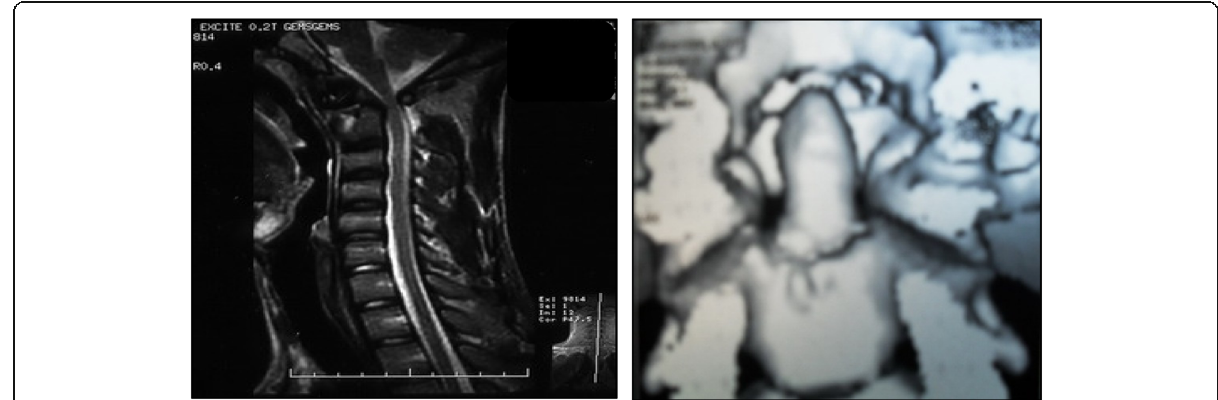
Fig. 3 MRI cervical spine and coronal 3D CT shows odontoid fracture type II